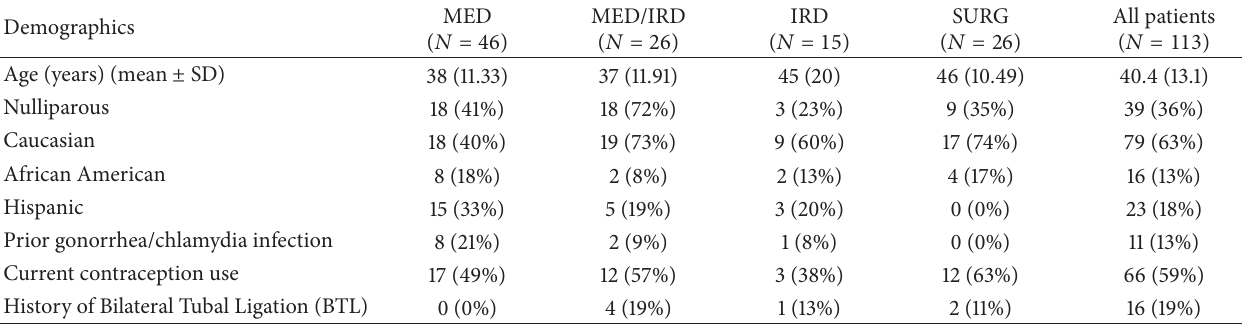
Table 1: Demographic characteristics by treatment group.